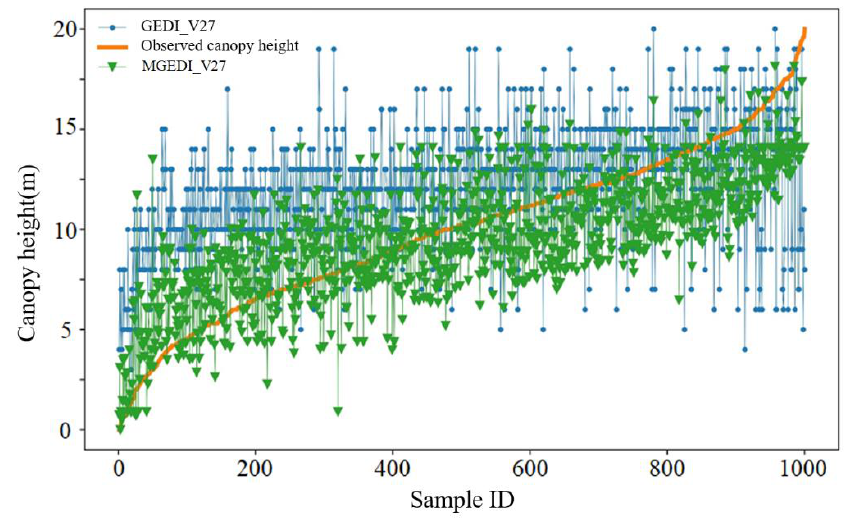
Figure 14. Comparison of canopy height of the GEDI_V27, the MGEDI_V27, and the observed canopy height.